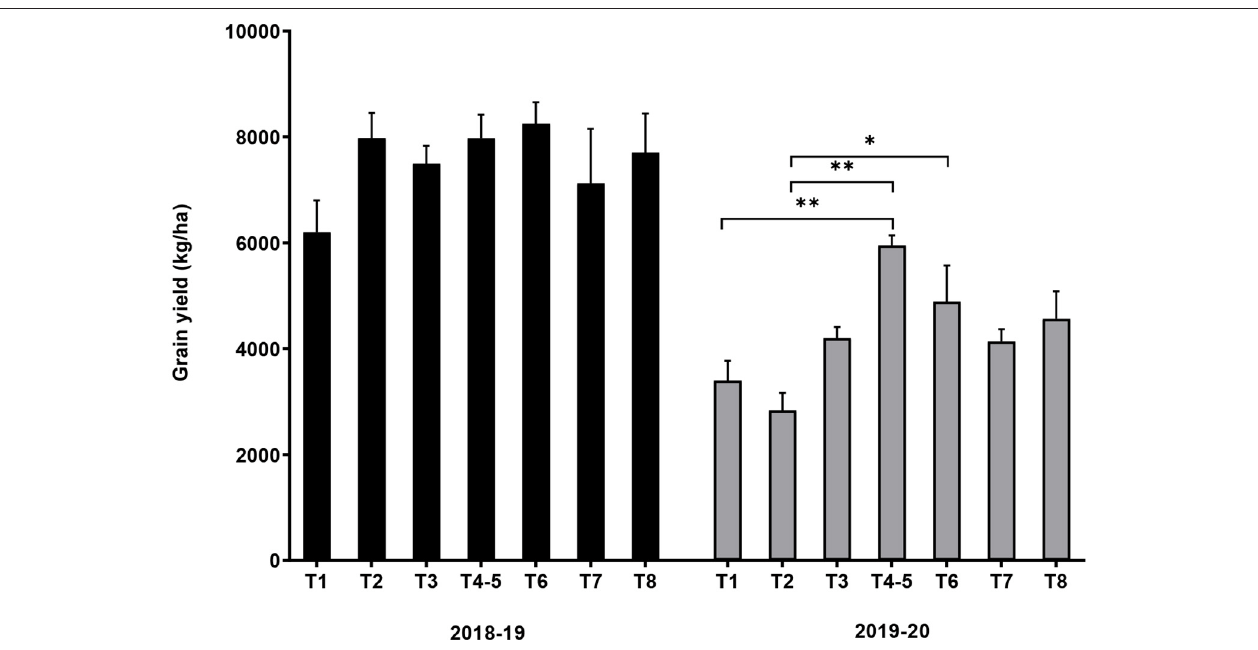
FIGURE 4 | Effect of conservation agriculture on grain yield of maize variety DKC 9089 during two seasons of field trials. Error bars represent SEM. *and **mean significant at 0.05 and 0.01, respectively, Tukey’s HSD test. Treatments: T1 = conventional agriculture; sole maize. T2 = conservation agriculture (CA); basin sowing; sole maize. T3 = CA; dibble stick sowing; sole maize. T4–5 = CA; dibble stick sowing; maize-cowpea rotation. T6 = CA; dibble stick sowing; maize-pigeon pea intercrop. T7 = CA; dibble stick sowing; maize-cowpea intercrop. T8 = CA; dibble stick sowing; maize-velvet bean